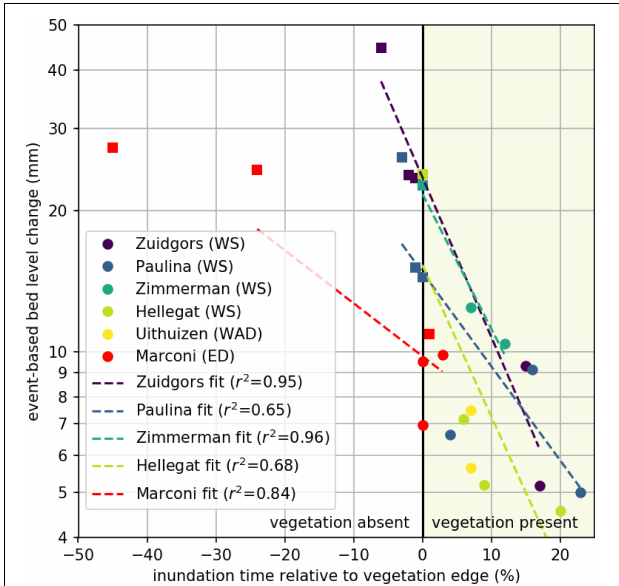
FIGURE 8 | Event-based bed level change related to the inundation time relative to the vegetation edge, with unvegetated (left part; square markers) and vegetated (right part; round markers) measurement stations. Data per study site is fitted with a logarithmic fit (dashed